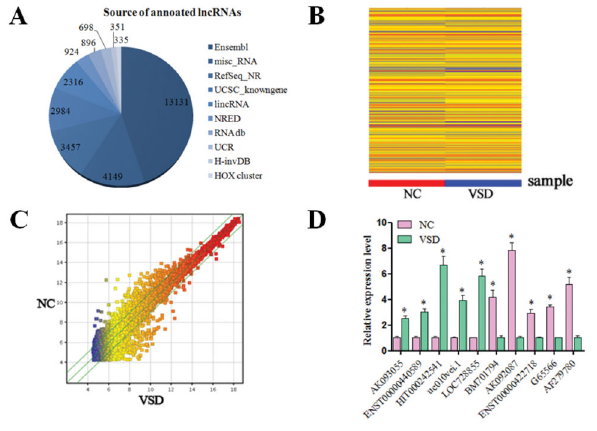
Figure 1. Profile of microarray. ( A ) Microarray v2.0 Figure 2. General characteristics of dysregulated lncRNAs